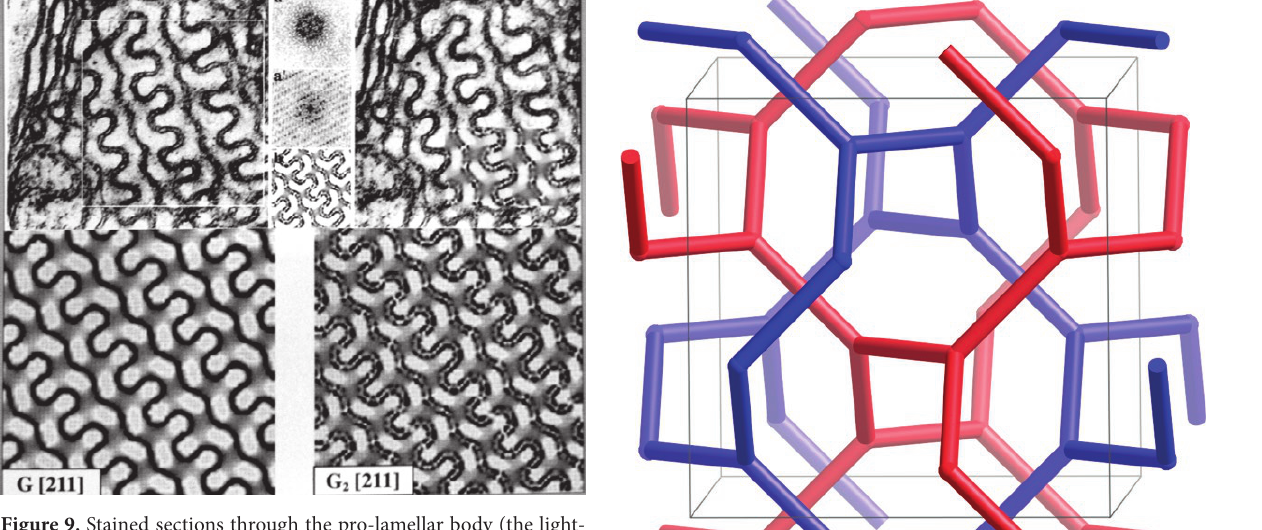
Figure 9. Stained sections through the pro-lamellar body (the light- harvesting photosynthetic centre) of a dark-adapted plant. (Insets: Fits due to Landh, described later in the text.) Adapted from HYDE et al. (1997).